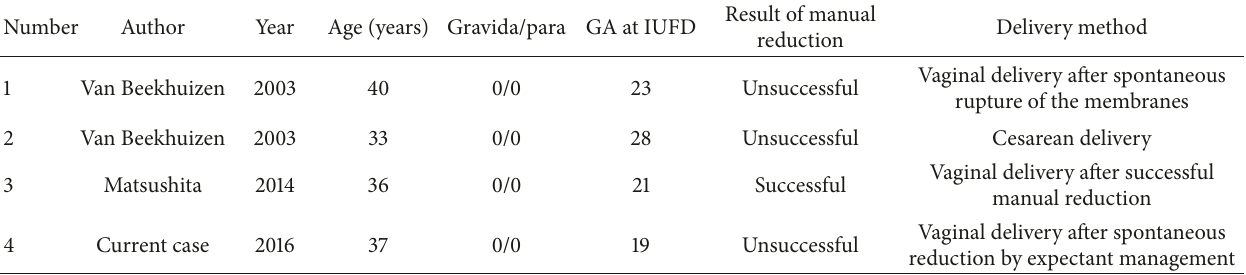
Table 1: Summary of cases of IUFD in the second or third trimester in women with an incarcerated